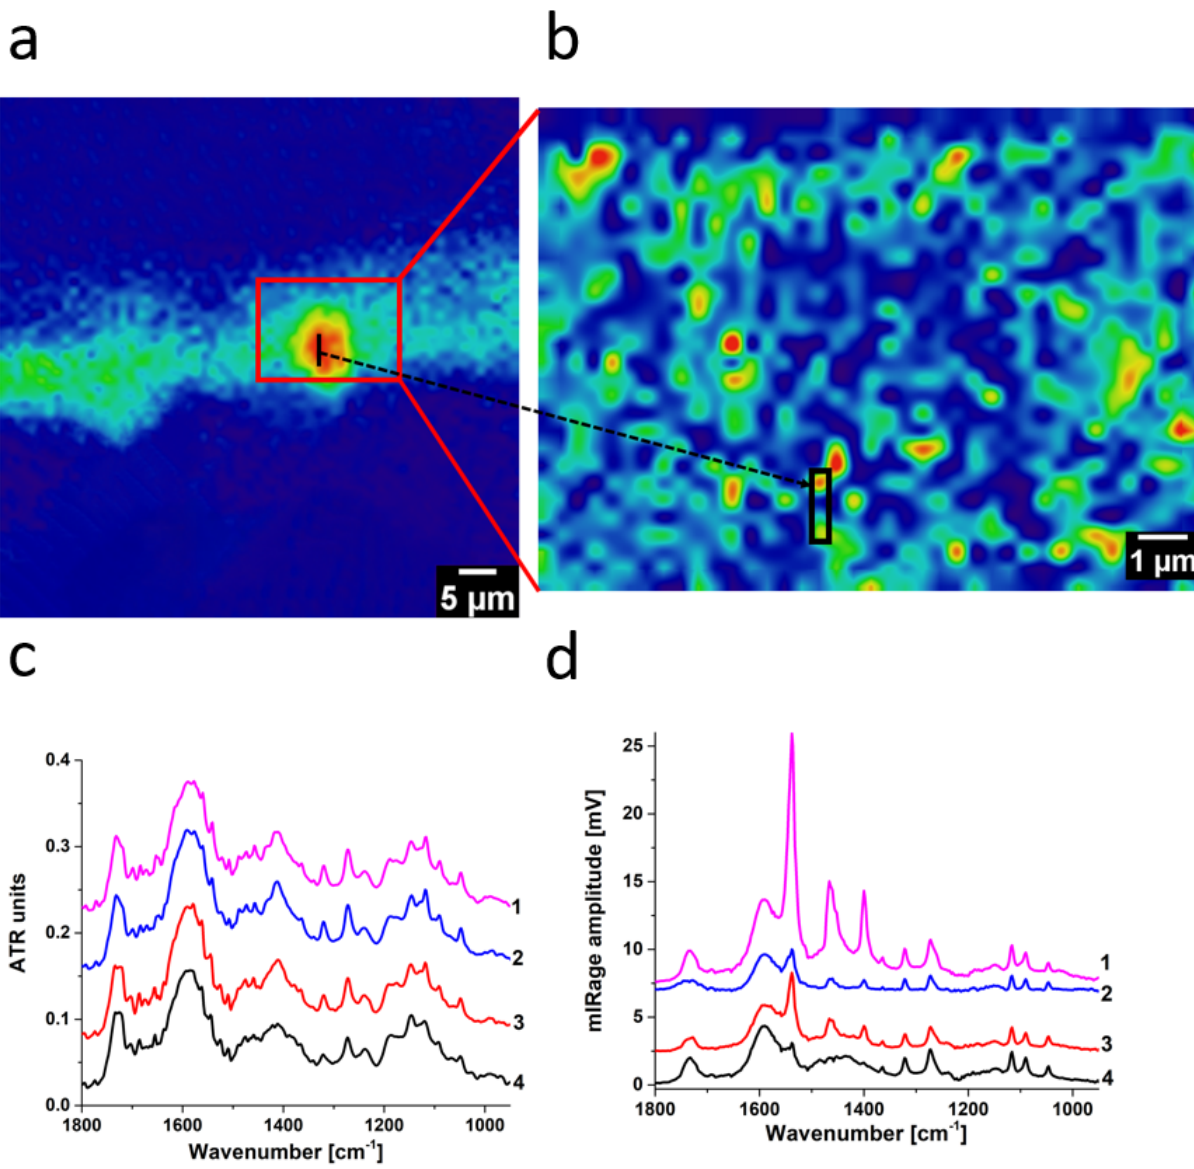
Figure 4. Comparison of the ATR–FTIR (FPA) and O-PTIR results: distribution of the integral calculated for 1270 cm -1 for zinc lactate collected for ( a ) ATR–FTIR and ( b ) O-PTIR. Red rectangle in ( a ) denotes the area in ( b ) analysed by O-PTIR spectroscopy. Four consecutive spectra are recorded from the points marked as ( a ) black line, ( b ) black rectangle. Distance between spectra is 1.1 µm for ( c ) ATR–FTIR and 0.5 µm for ( d ) O-PTIR.